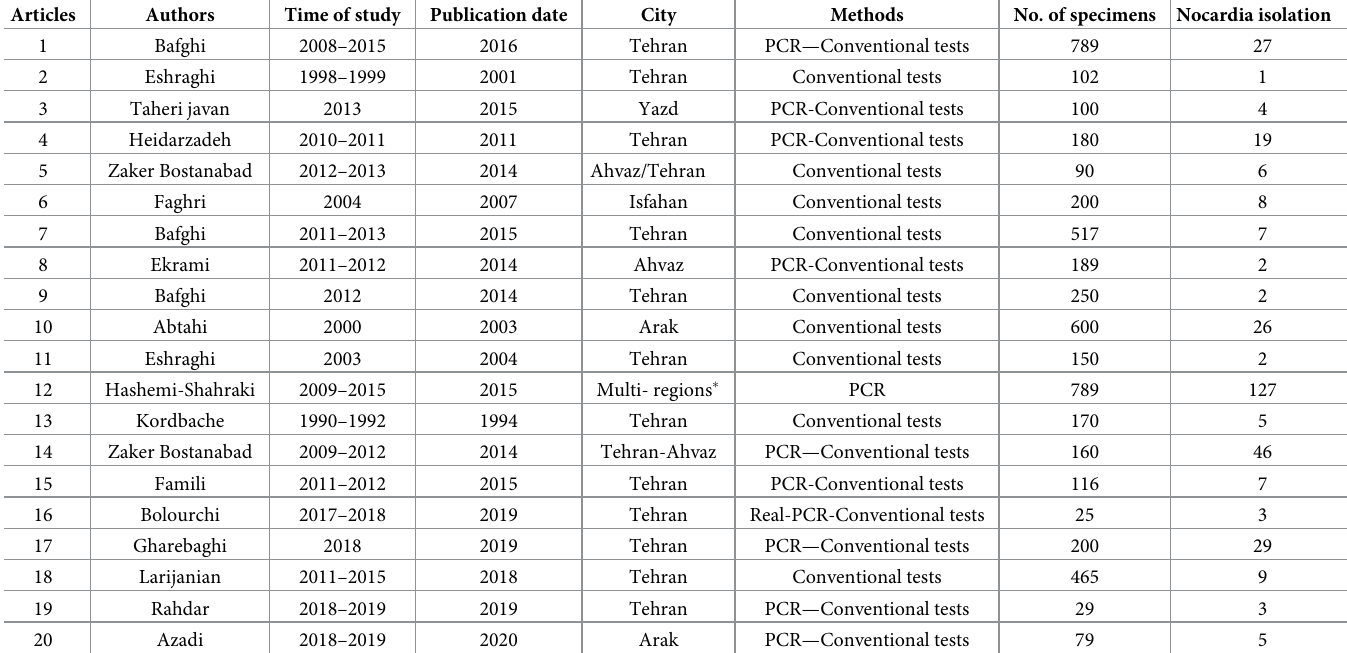
Table 1. Characteristics of studies involved in the current systematic review and